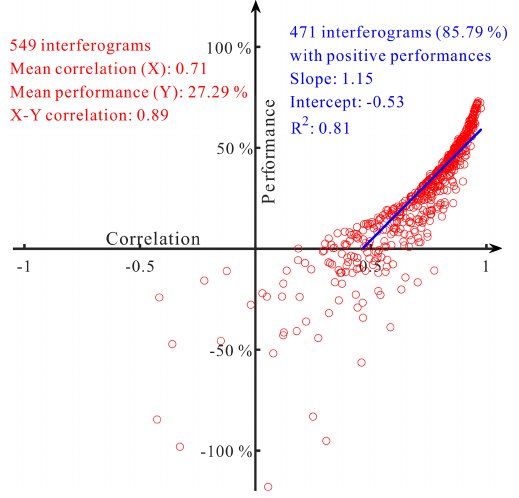
Figure 6. Correlation analysis of the phase-dZTD indicator and GACOS performance.